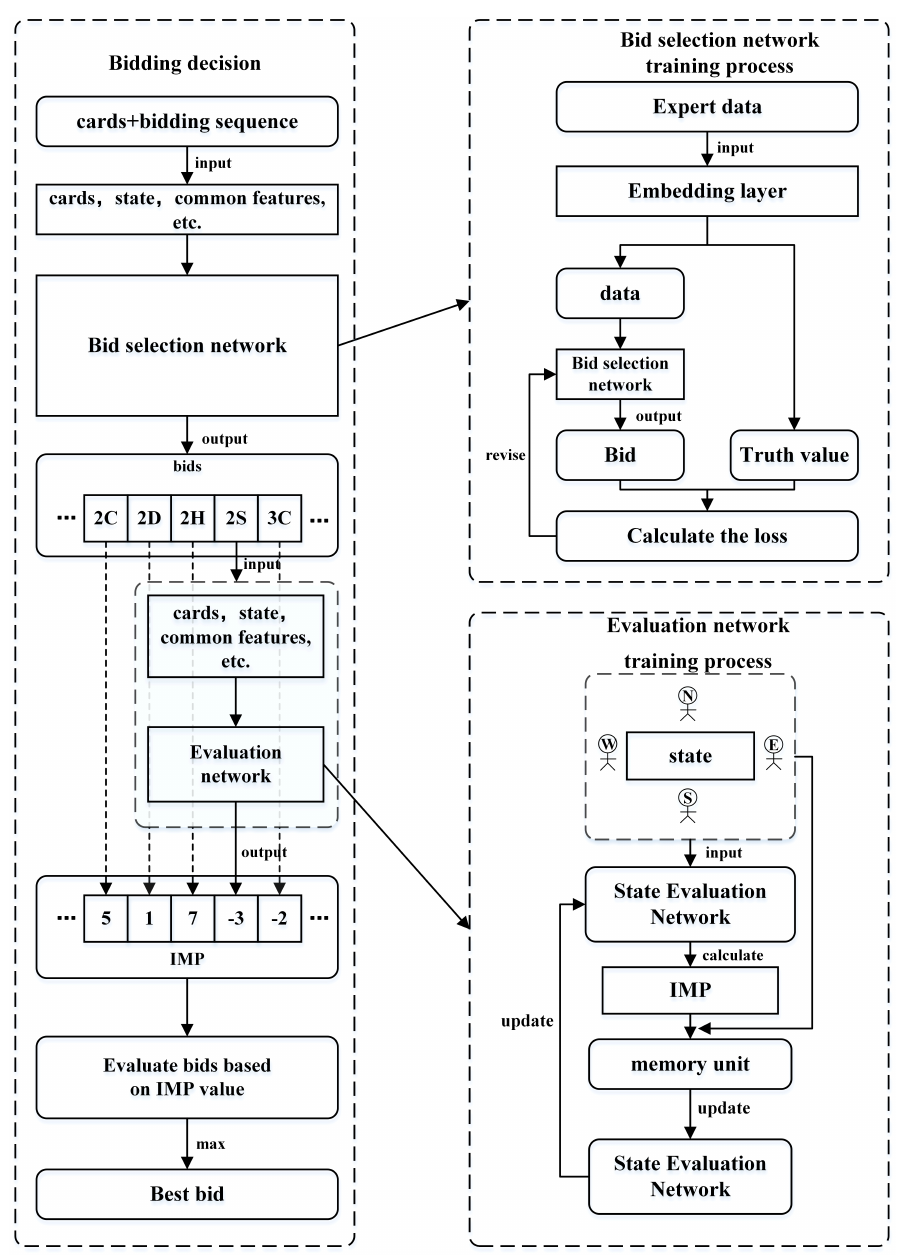
Figure 1. An overview of the proposed framework. It includes two phases: bid selection model and evaluation